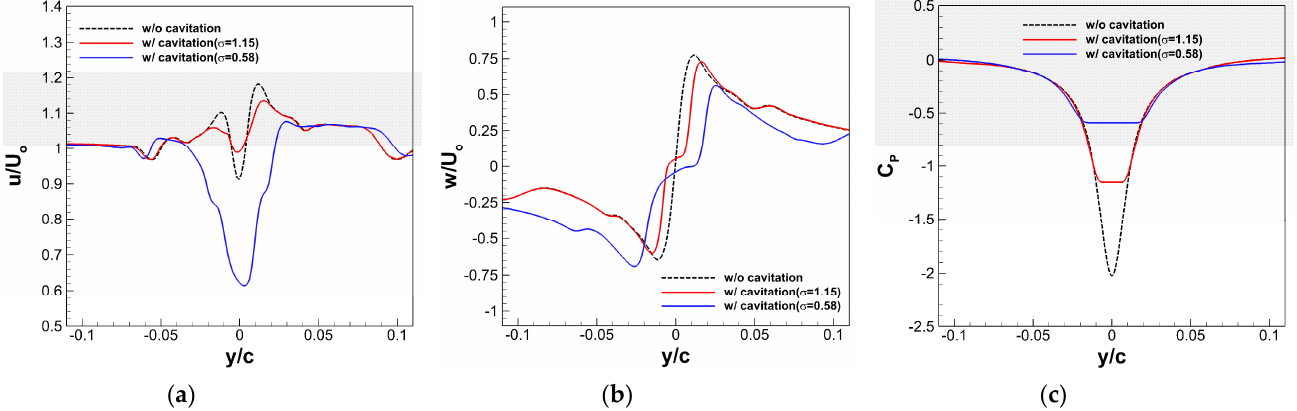
Figure 14. Pressure, axial and vertical profiles at x/c = 1.0 for different flow conditions: ( a ) axial velocity; ( b ) vertical velocity; ( c ) pressure coefficient.